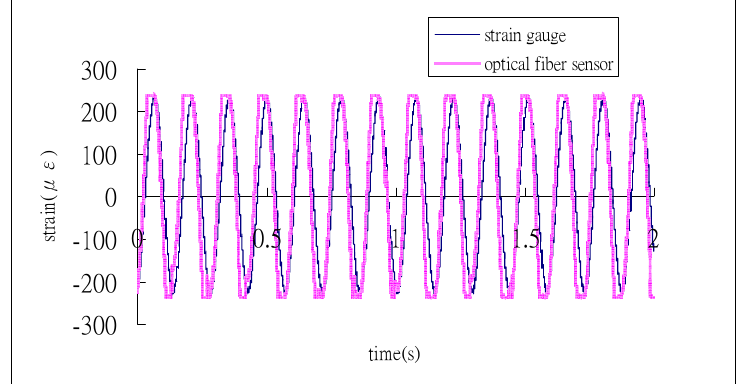
Figure 9. Dynamic strain of a cantilever beam subjected to base excitation frequency 7